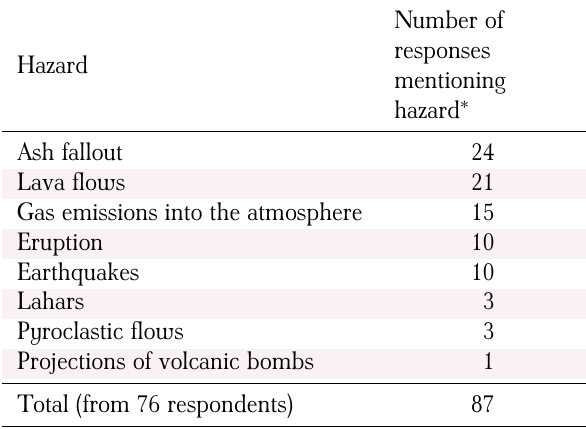
Table 2: Main hazards related to the volcano cited by the re- spondents.